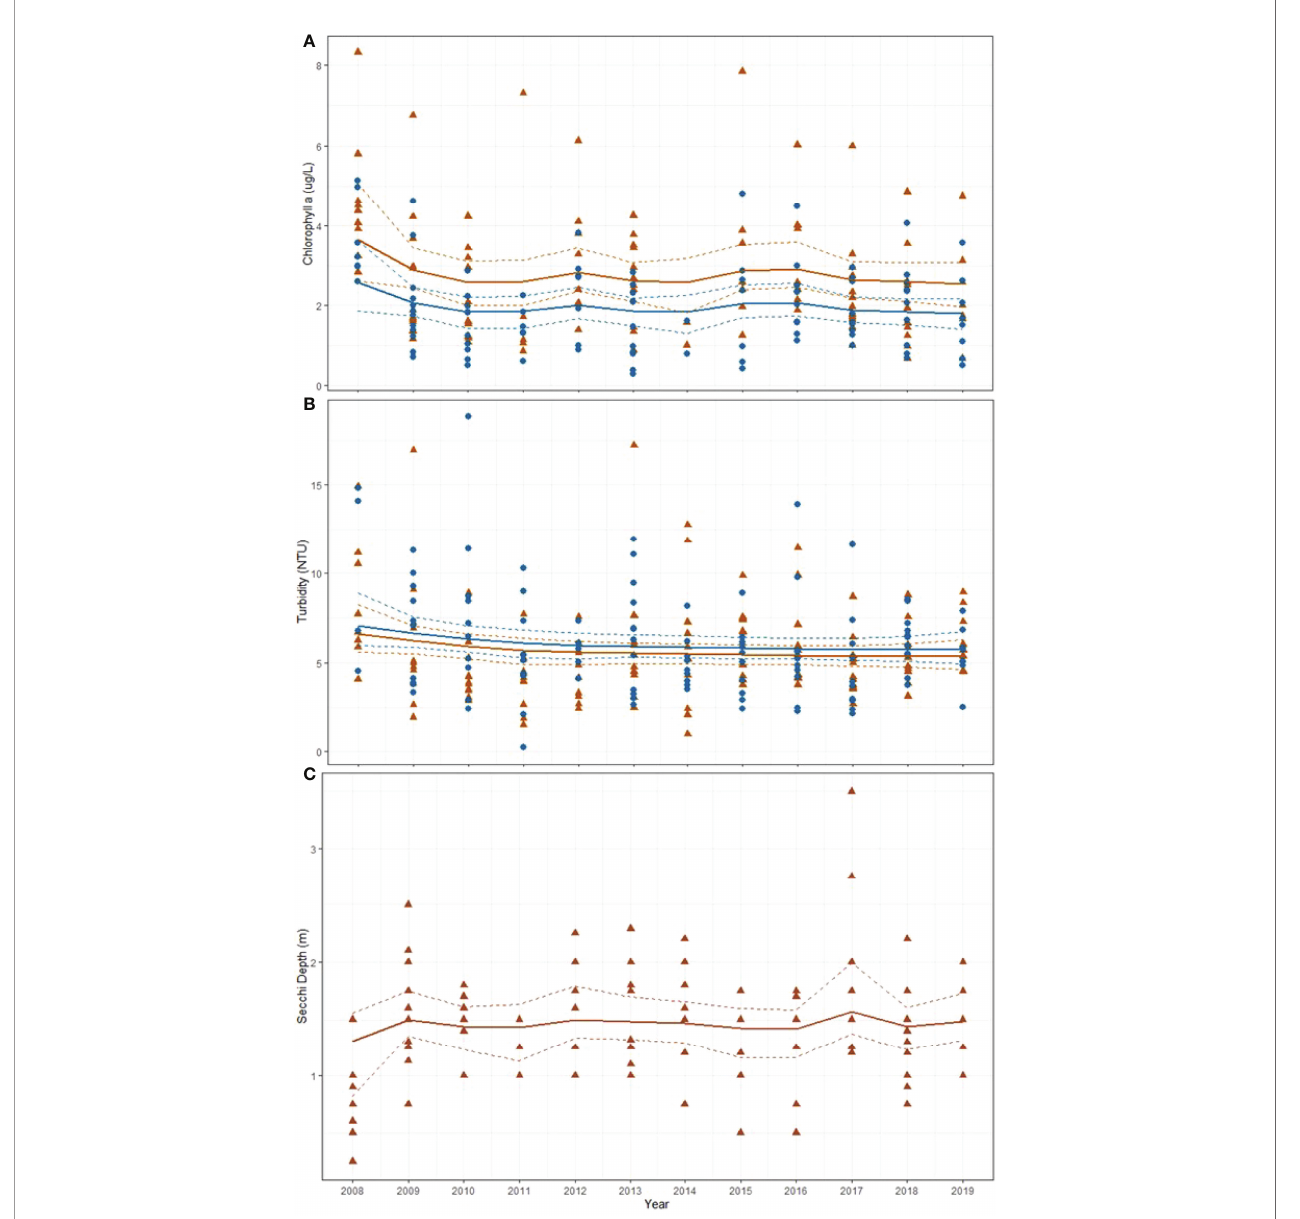
FIGURE 9 | Monthly (A) chlorophyll a (ug/L), (B) mean turbidity (NTU), and (C) secchi depth (m) at WQ2 (brown triangles) and WQ3 (blue circles) in Back Sound NC. Solid lines represent mean fi tted values from gamma regression with temporal correction factor and dotted lines represent 95% con fi dence